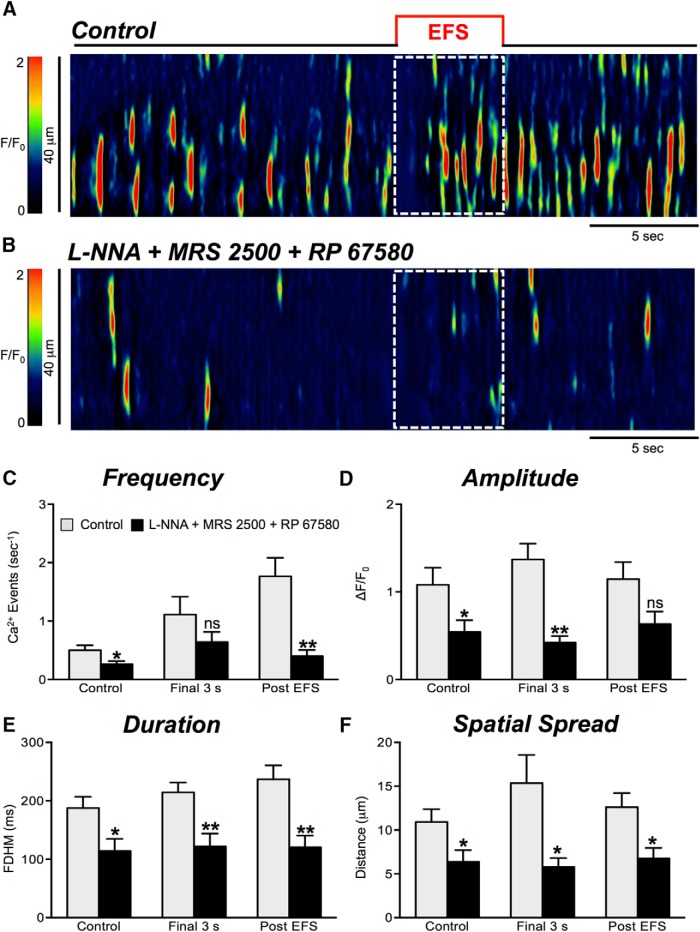
Excitatory responses are strongly attenuated by NK1 antagonist. A, B, Representative ST maps showing the inhibitory effects of RP 67580 (1 μM), in the presence of nitric oxide synthase inhibitor L-NNA (100 μM) and purinergic P2Y1 receptor antagonist (MRS 2500; 1 μM) on Ca2+ transients in response to nerve stimulation (EFS at 10 Hz 5 s; indicated by the red line and dotted white box in ST maps). C–F, Summary data showing the effects of a combination of L-NNA, MRS 2500, and RP 67580 on Ca2+ transient frequency (C), amplitude (D), duration (E), and spatial spread (F) in ICC-DMP during the control period, during the final 3 s of EFS, and during the post-EFS period (5 s), n = 4, c = 13; ns = p > 0.05, **p < 0.01.